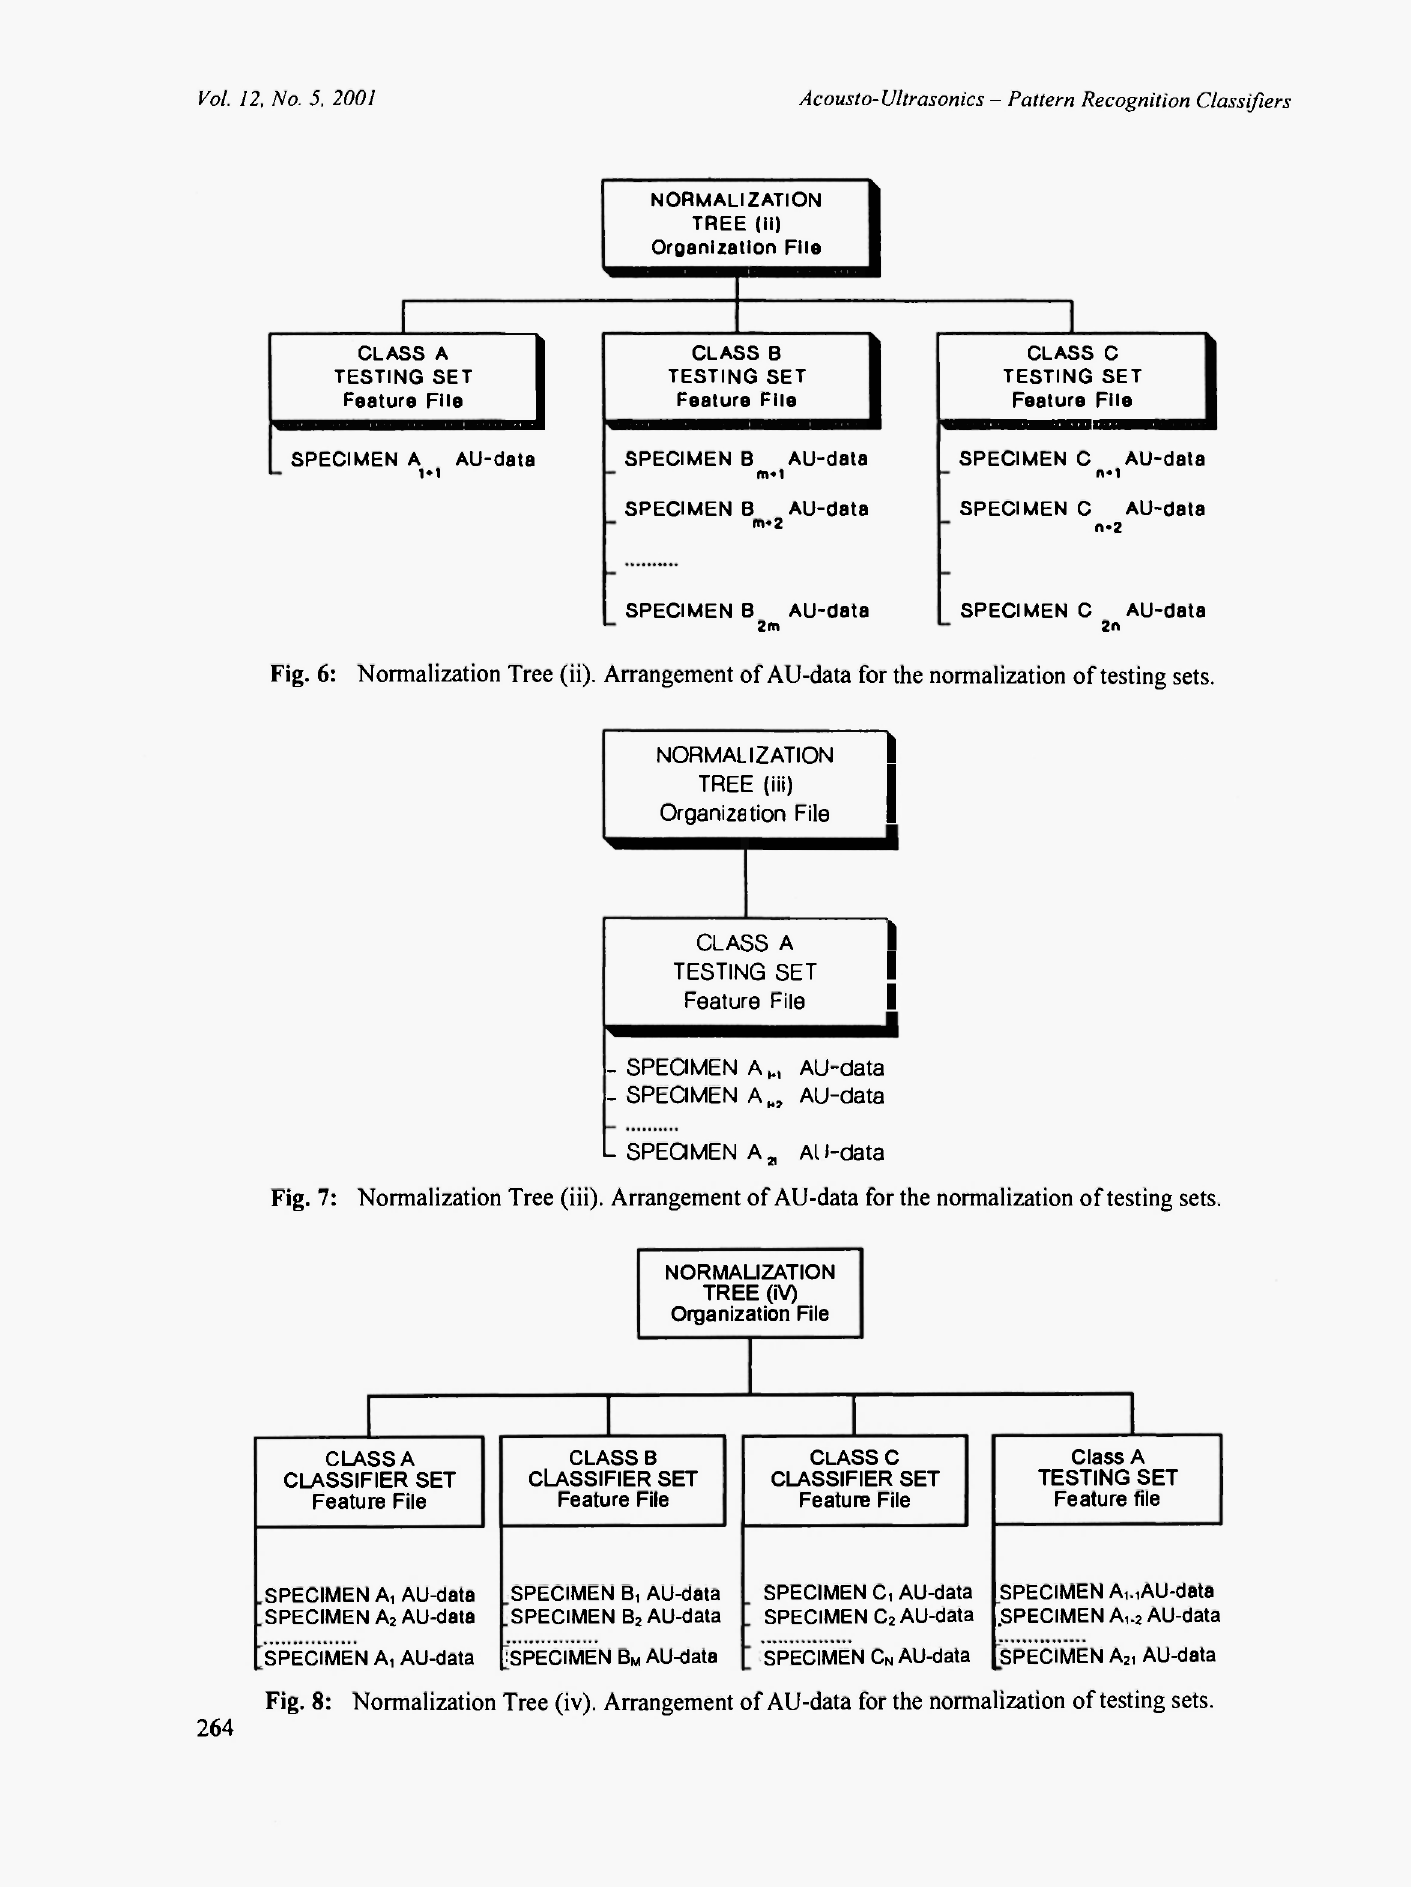
Fig. 8: Normalization Tree (iv). Arrangement of AU-data for the normalization of testing